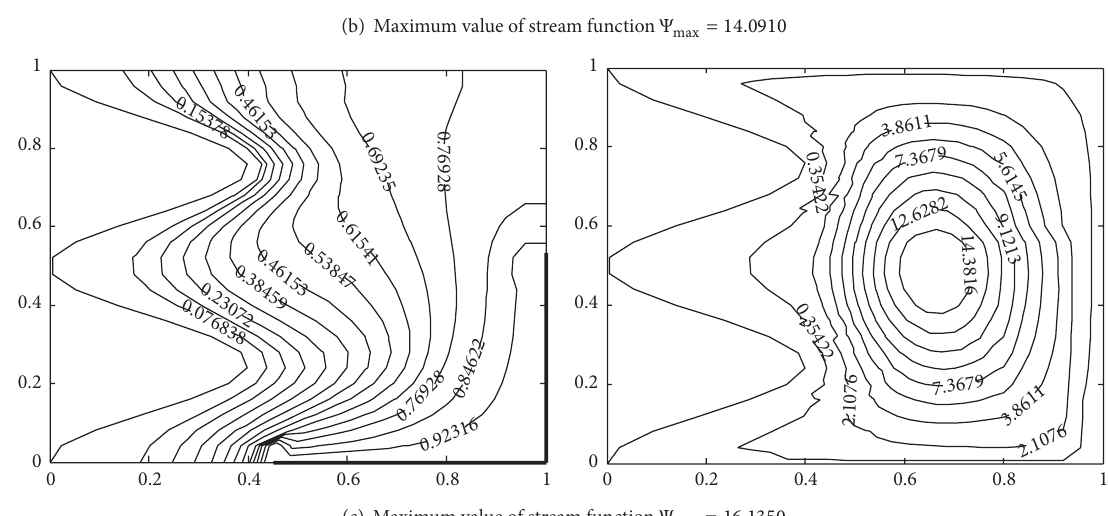
(c) Maximum value of stream function Ψ max = 16.1350 Figure 8: Temperature contours (on the left) and streamlines (on the right) with different wavy surface amplitudes at Ra = 10 5 , Pr = 0.7 , 𝑛 = 2 , ℎ𝑥 = 0.55 , ℎ𝑦 = 0.55 , (a) 𝐴 = 0.1 , (b) 𝐴 = 0.2 , and (c) 𝐴 = 0.4